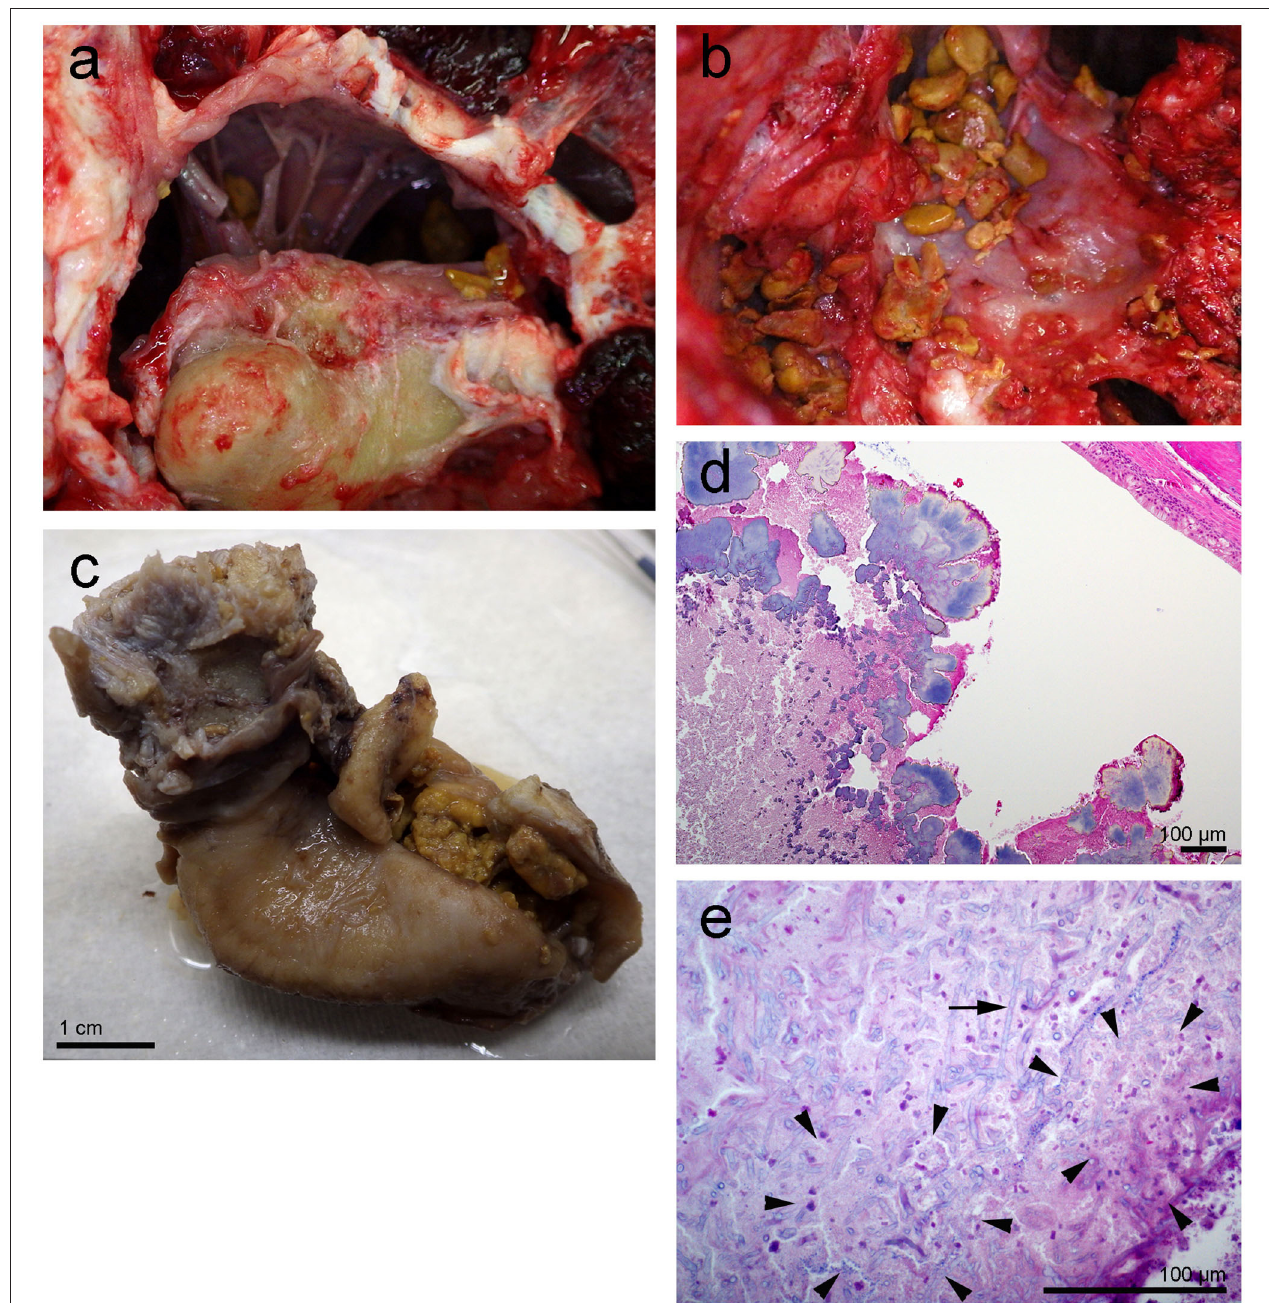
FIGURE 2 | Left tympanic bone from the beluga Qila. The gross images, (a,b) were taken during the necropsy and dissection of the ears. Note the smooth nodular tan yellow precipitates in the peribullar (a,b) and tympanic cavities (c) . Image (b) was obtained after the removal of the tympano-periotic complex. (d,e) Histopathology of hematoxylin-eosin stained left tympanic bone and cavity with numerous lobules of bacteria (d) and florid fungal hyphae interspersed [arrow in (e) ] within inflammatory infiltrate and necrotic debris [regions delimited by arrowheads in (e) ].